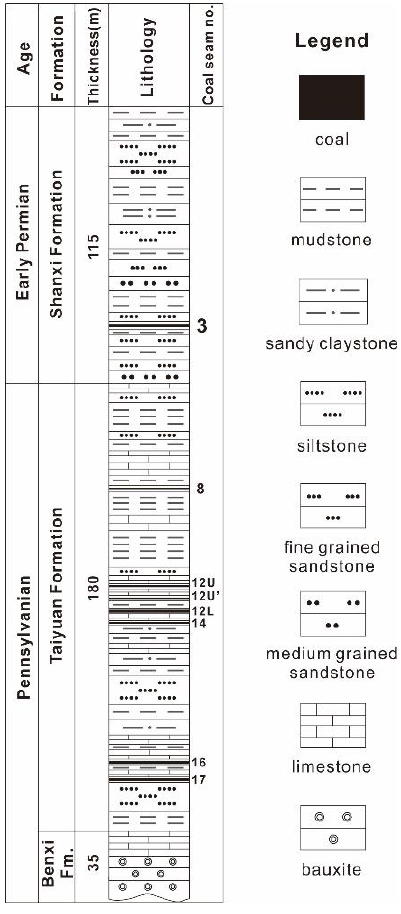
Figure 2. Stratigraphic section through the Tengxian coalfield, modified from Zhu [31].